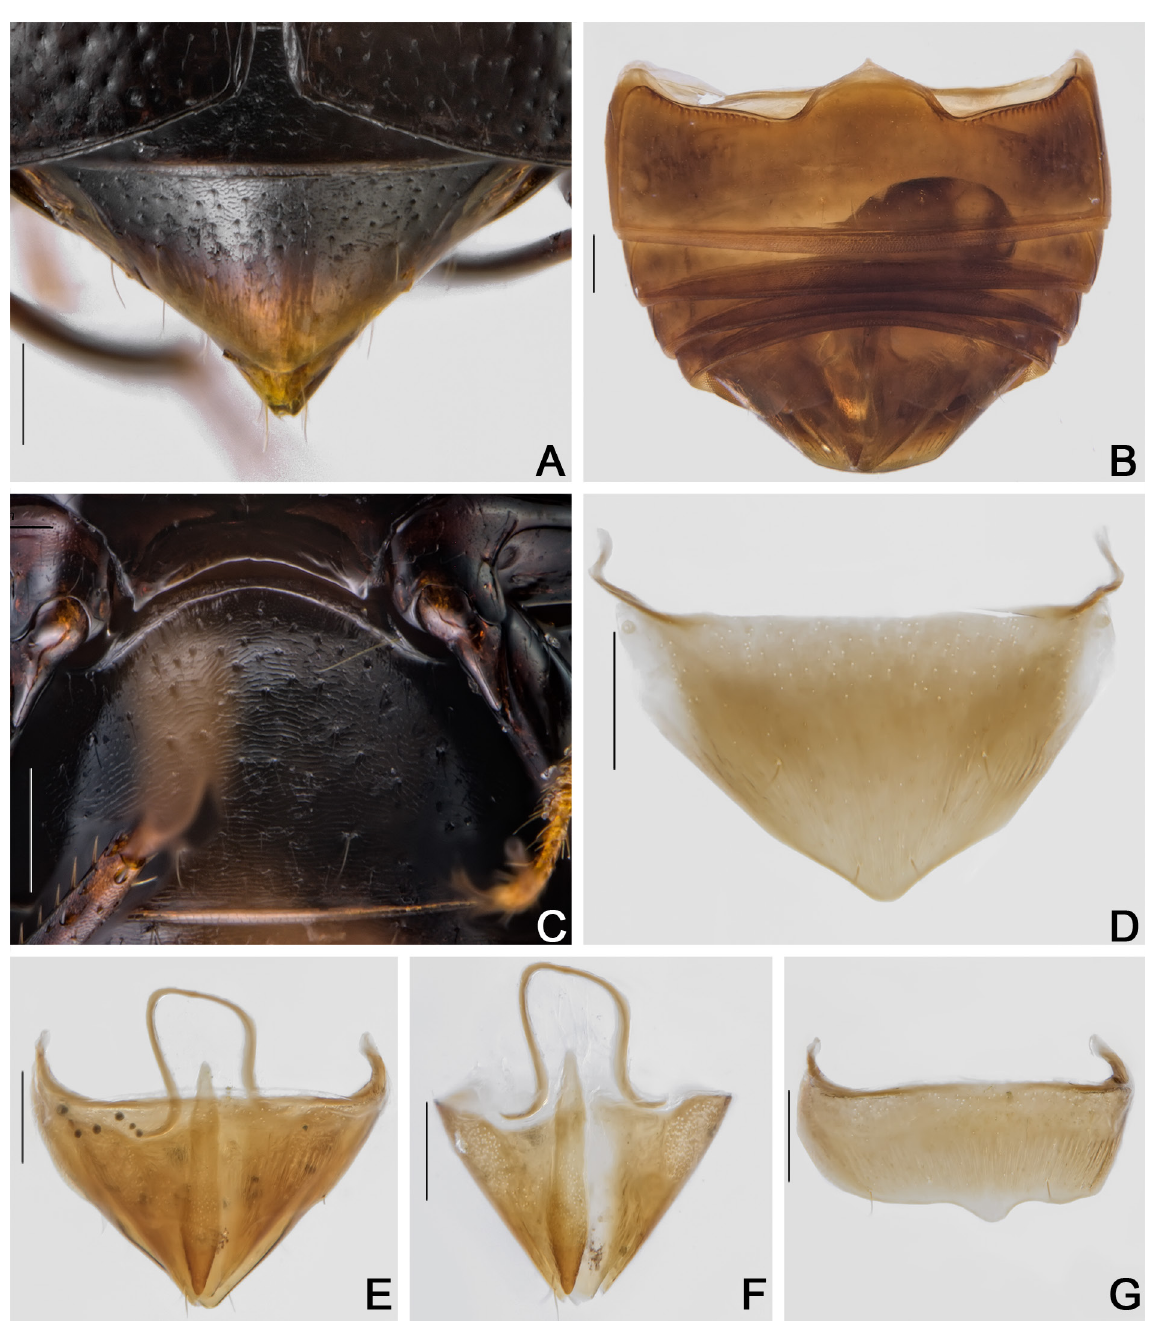
Fig. 27. Cyparium loebli sp. nov. A–C . Holotype, ♂ (CELC). D–G . Paratype, ♂ (CELC). A . Abdomen, dorsal view. B . Abdomen, ventral view. C . Ventrite 1. D . Tergite VIII. E . Terminalia. F . Tergite IX. G . Sternite VIII. Specimens collected at Mata do Paraíso, Viçosa (MG, Brazil). Scale bars = 0.2